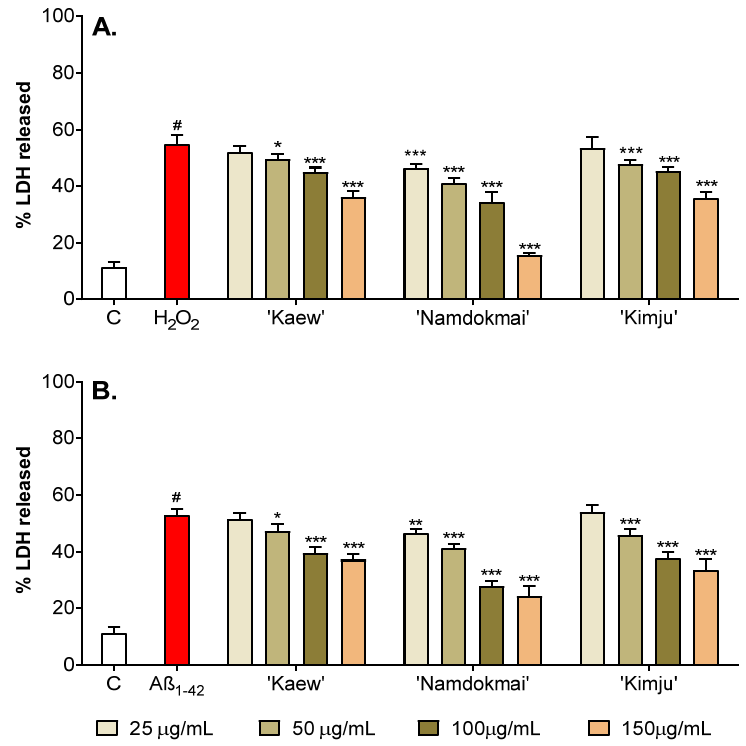
Figure 3. Neuroprotective effect of fruit extracts ( M. indica ‘Kaew’, M. indica ‘Namdokmai’, and P. guajava ‘Kimju’) on oxidative damaged PC-12 cells examined using a lactate dehydrogenase (LDH) assay. Percentage of LDH released in PC-12 cells induced by ( A ) H 2 O 2 and ( B ) A β 1–42 was compared to the untreated control group, while co-treatment between selected fruit extracts at different concentrations (25, 50, 100 and 150 µ g/mL) and oxidative inducers were compared to its oxidative inducer treated group. C: untreated control; H 2 O 2 : H 2 O 2 -treated control; A β 1–42 : A β 1–42 -treated control; # significance at p < 0.05 compared to the untreated control, * significance at p < 0.05, ** significance at p < 0.01 and *** significance at p < 0.001 compared with either H 2 O 2 - or A β 1–42 -treated cells using one-way analysis of variance (ANOVA) followed by Tukey’s multiple comparisons